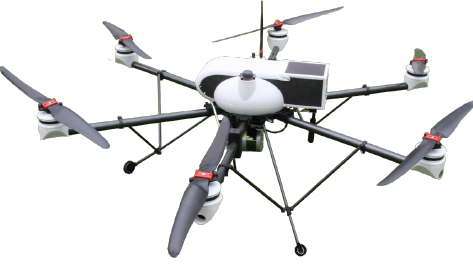
Figure 2. AR200 UAV by